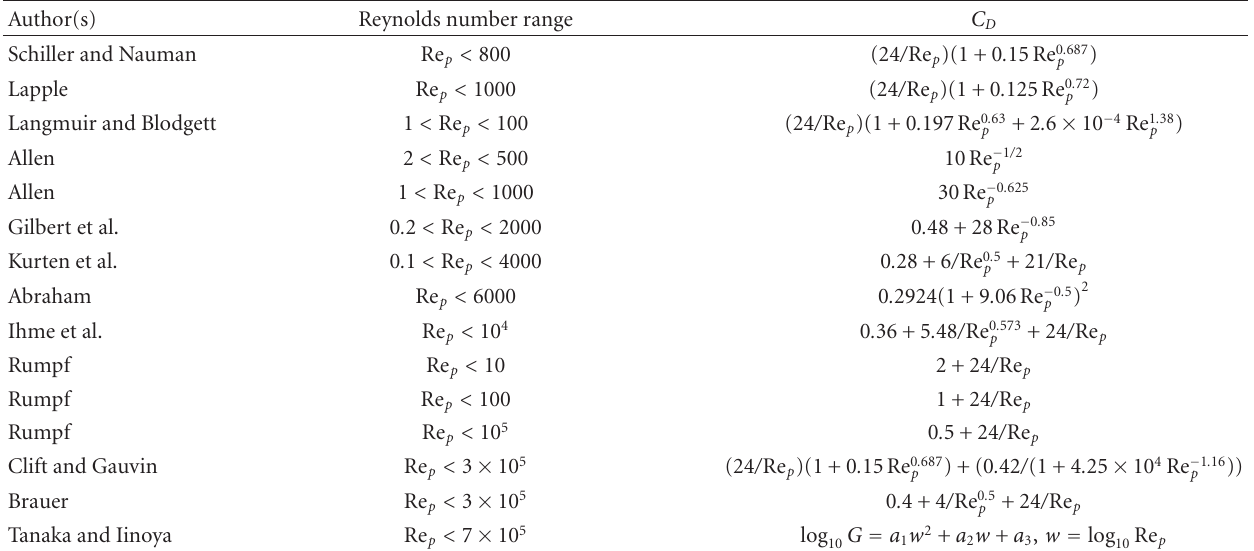
Table 3: Summary of literature for drag coe ffi cients at di ff erent Reynolds numbers, reprinted from Clift et al. [56], Copyright 2005, with permission from Dover Publications,